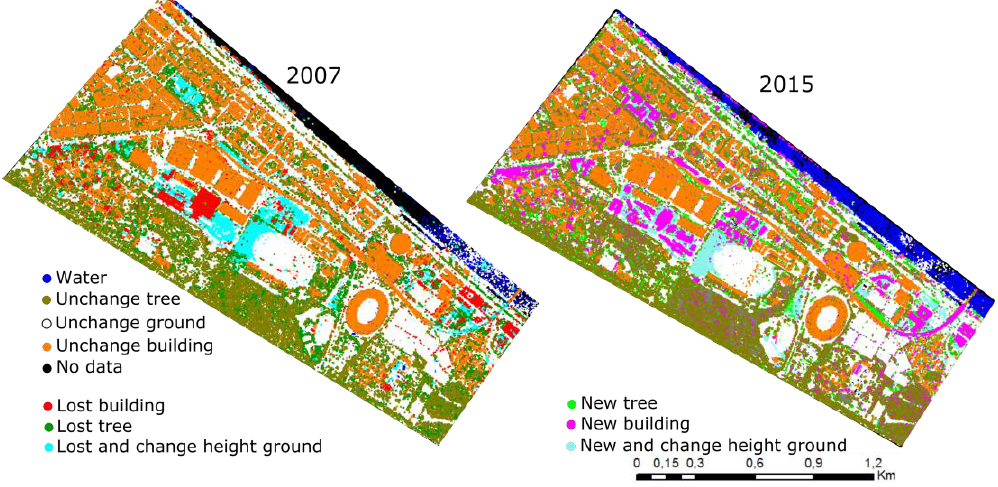
Figure 6. Change detection classification results of 2007 and 2015 datasets.